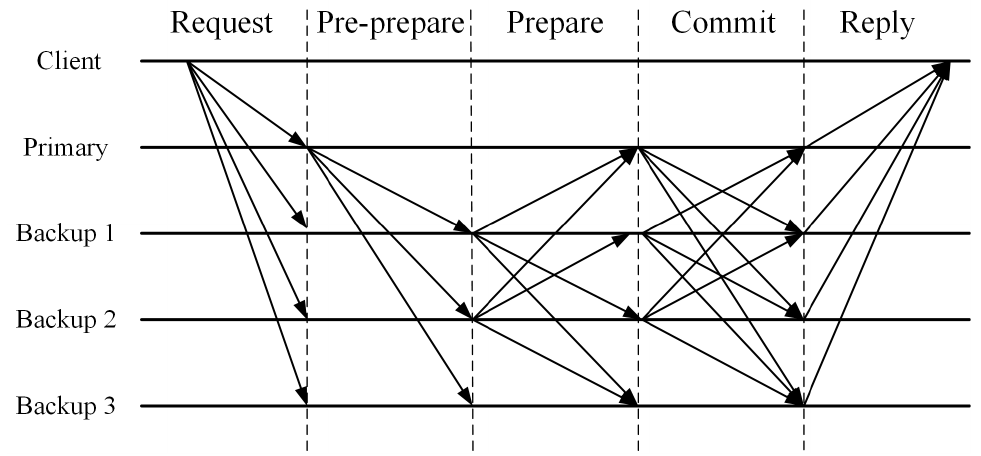
Figure 1. The operation of the PBFT